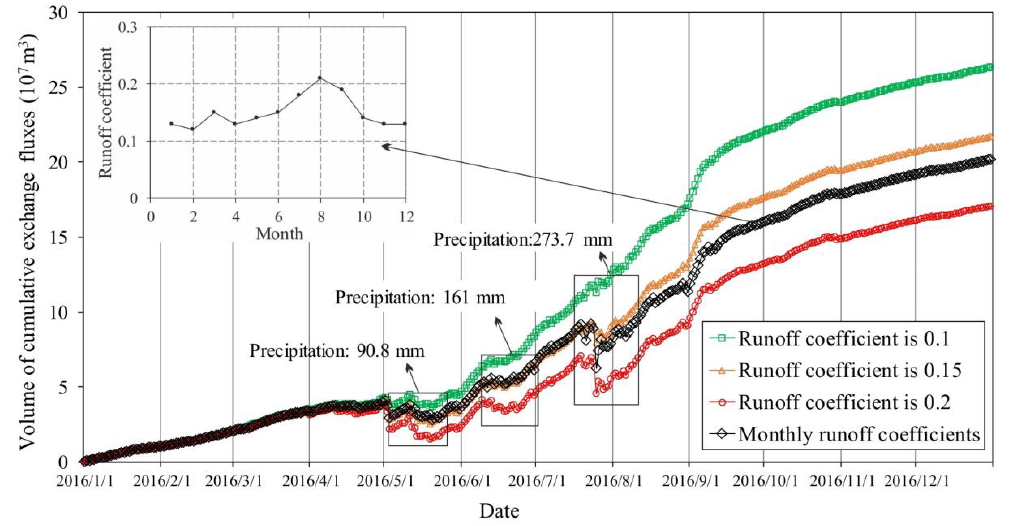
Figure 7. E ff ect of selection of di ff erent runo ff coe ffi cients on the results of exchange Figure 7. Effect of selection of different runoff coefficients on the results of exchange fluxes.